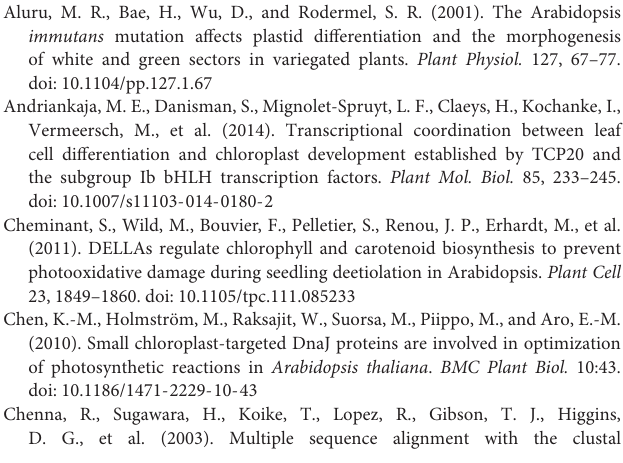
FIGURE S1 | Nucleotide and deduced amino acid sequence of DY1. Predicted cleavage site after the chloroplast transit peptide is indicated by a black arrow. Peptide fragment used for raising antiserum against DY1 is underlined. FIGURE S2 | DY1 interacts with a RAB GTPase homolog protein At4g20360. (A) Yeast two-hybrid analysis of the interaction between DY1 and At4g20360. DY1 and At4g20360 were cloned into pDEST32 and pDEST22, respectively. Yeast AH109 cells were co-transformed with a combination of these plasmids, and plated onto non-selective (SD/-Leu/-Trp, DDO) and selective (SD/-Leu/-Trp/-His/-Ade, QDO) plates in series dilution. (B) At4g20360 also localizes in